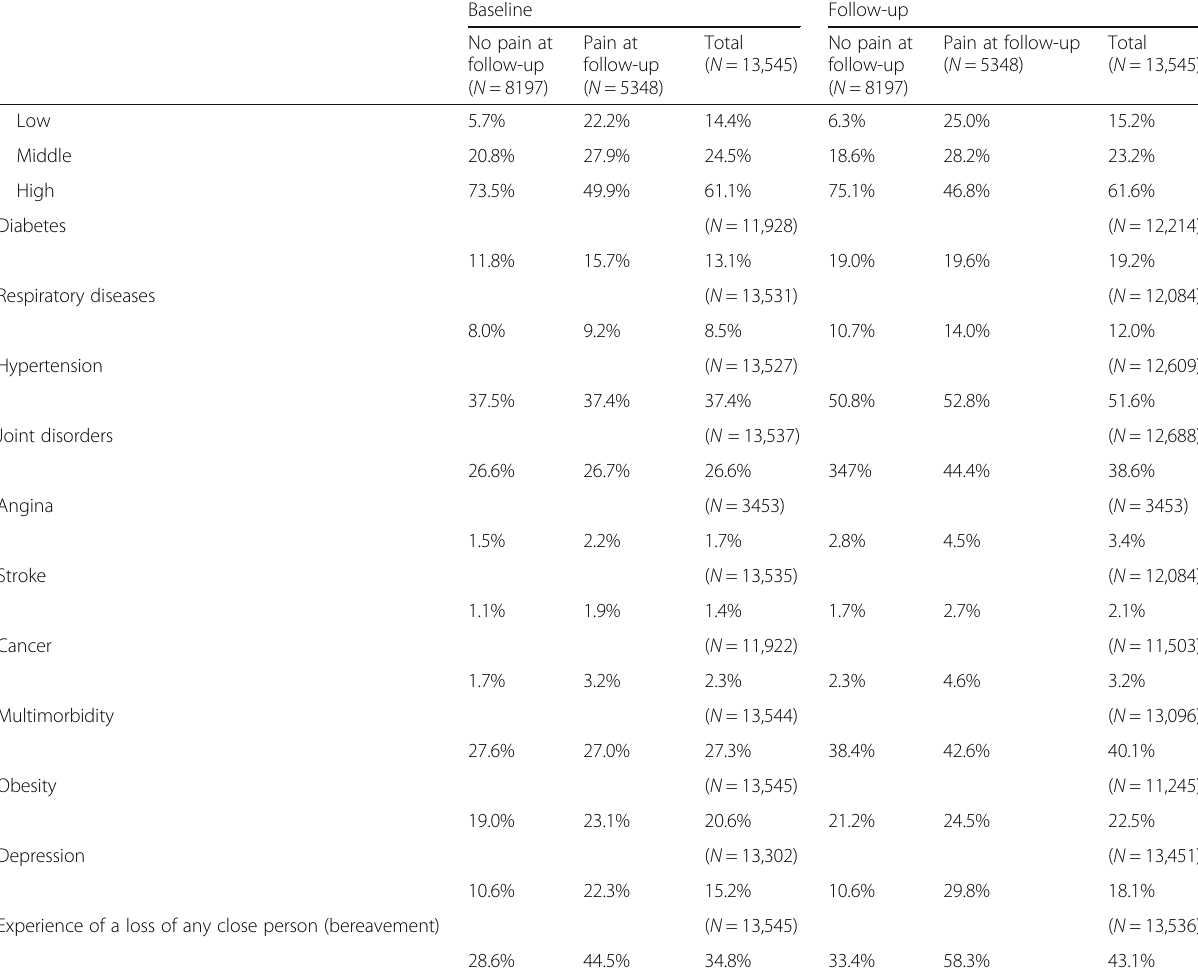
Table 1 Final regression model sample description